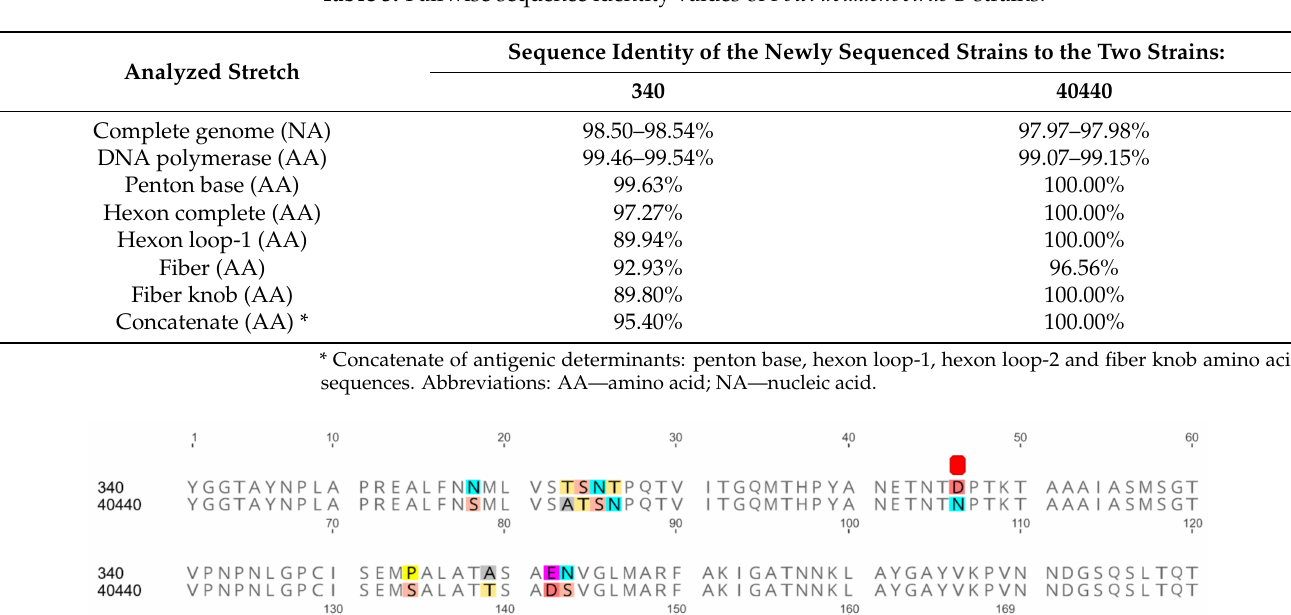
Table 3. Pairwise sequence identity values of Fowl aviadenovirus B strains.